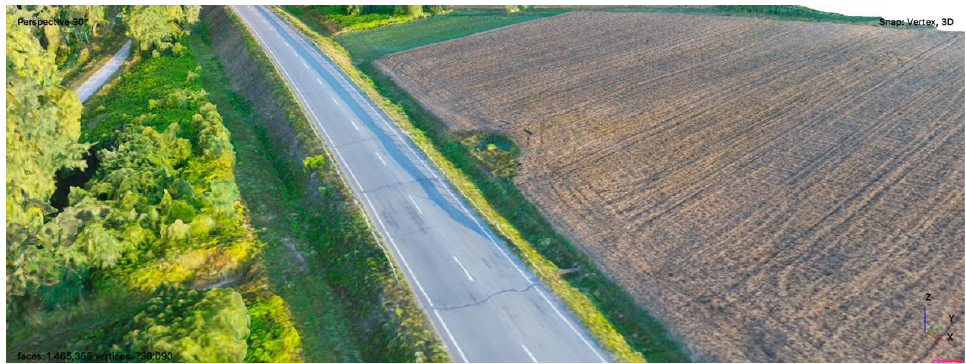
Figure 14. Three-dimensional visualization obtained as a result of the UAV flight over the zone of linear discontinuous deformations on the road surface.